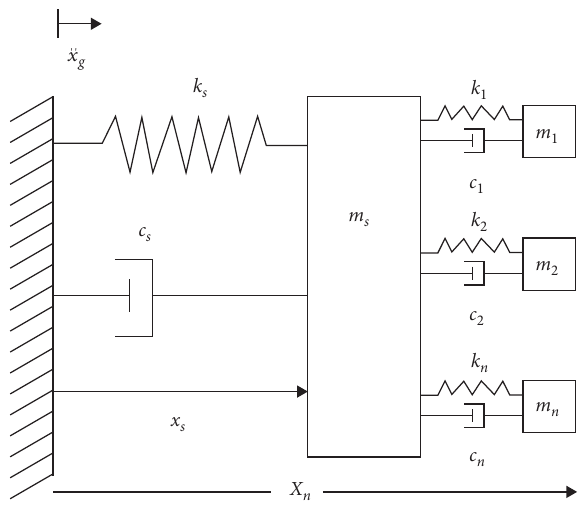
Figure 1: Structural model of MTMDs